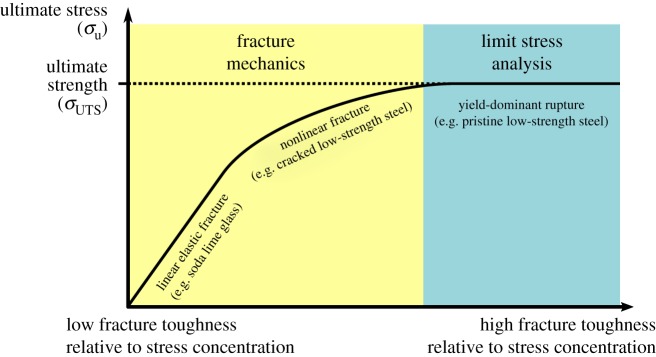
Schematic of ultimate stress variation with fracture toughness and stress concentration severity. Fracture mechanics governs failure when the material's fracture toughness is small relative to a local stress concentration. Limit stress analysis governs failure when the material is sufficiently tough to tolerate any stress concentrations that are present. In the fracture mechanics case, σu<σUTS; in the limit stress case, σu = σUTS [23,24,26].